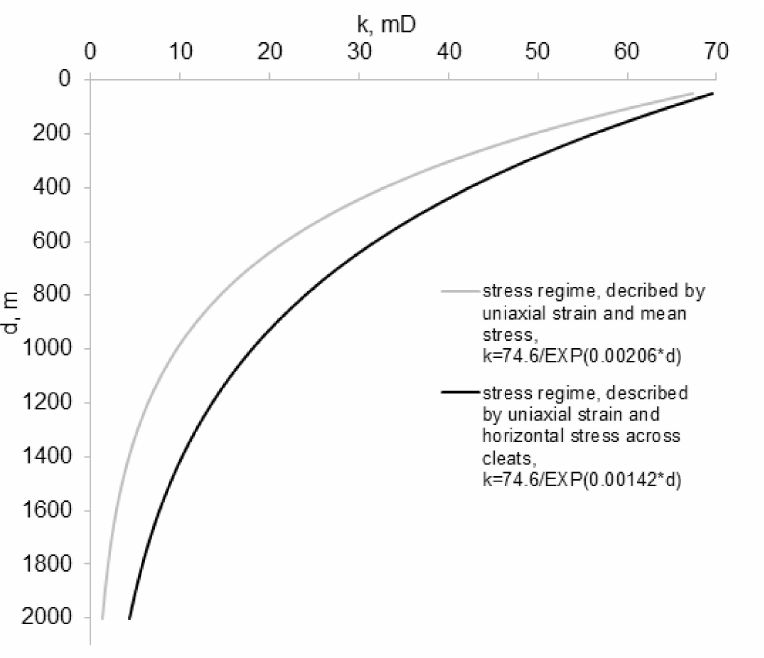
Figure 10. Permeability of the coking coals perpendicular to the butt cleat direction: permeability- depth dependence for stress regimes, described by uniaxial strain and mean stress (gray line) and horizontal stress across cleats (black